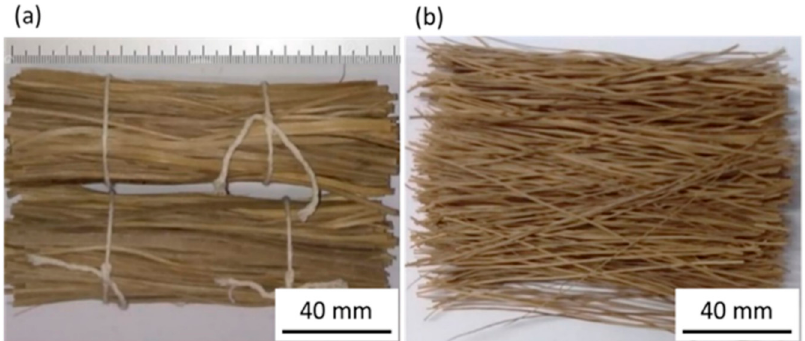
Figure 2. Titica vine as ( a ) splints and ( b ) bundle.